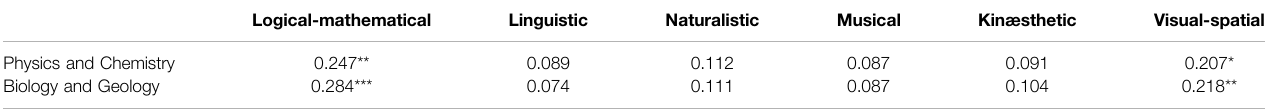
TABLE 4 | Spearman ’ s correlation coef fi cients between self-ef fi cacy in different scienti fi c areas and the students ’ intelligence pro fi les. Logical-mathematical